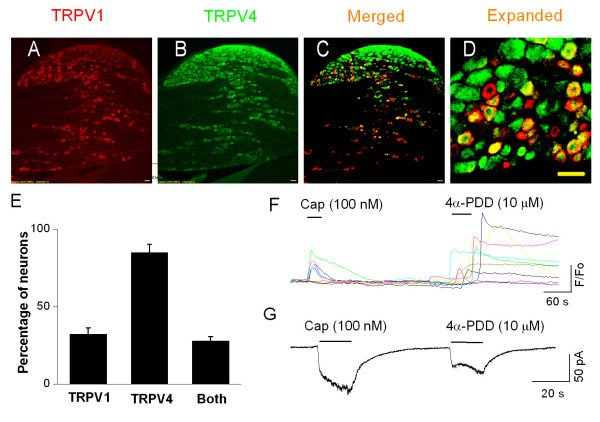
TRPV1 and TRPV4 are co-localized in dorsal root ganglion (DRG) neurons. A. Immunostaining of TRPV1 in DRG. B. Immunostaining of TRPV4 in DRG. C. Merged images of A and B. D. Expanded merged image. Bar = 50 μm. E. Summary graph showing the expression of TRPV1, TRPV4 and the extent of co-expression (n = 4). F. Ca2+ fluorescence imaging showing capsaicin- and 4α-PDD-induced responses in the same neurons. G. Whole-cell current trace showing capsaicin- and 4α-PDD-mediated current responses in the same neuron.